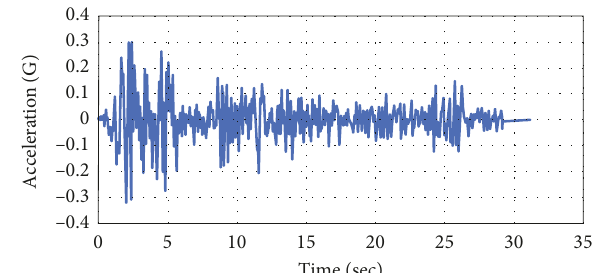
Figure 13: El centro accelerogram.